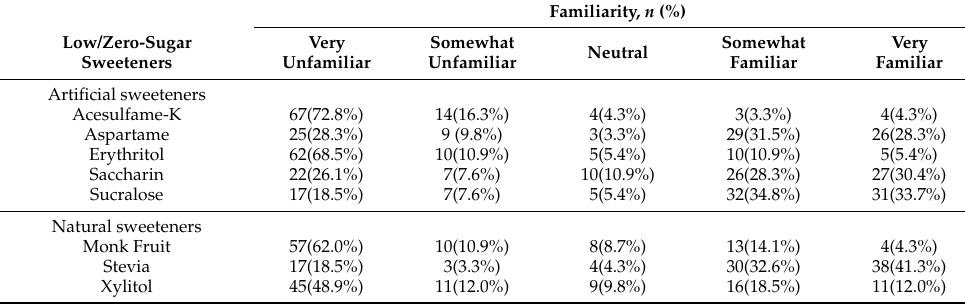
Table 4. Familiarity of various sweeteners selected by consumer panel ( n = 92).